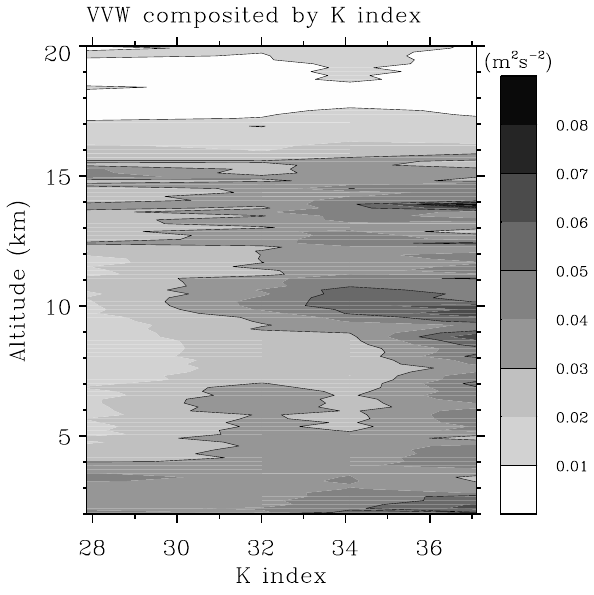
Fig. 12. Altitude profile of daily variance of vertical wind (VVW) composited by K index in November